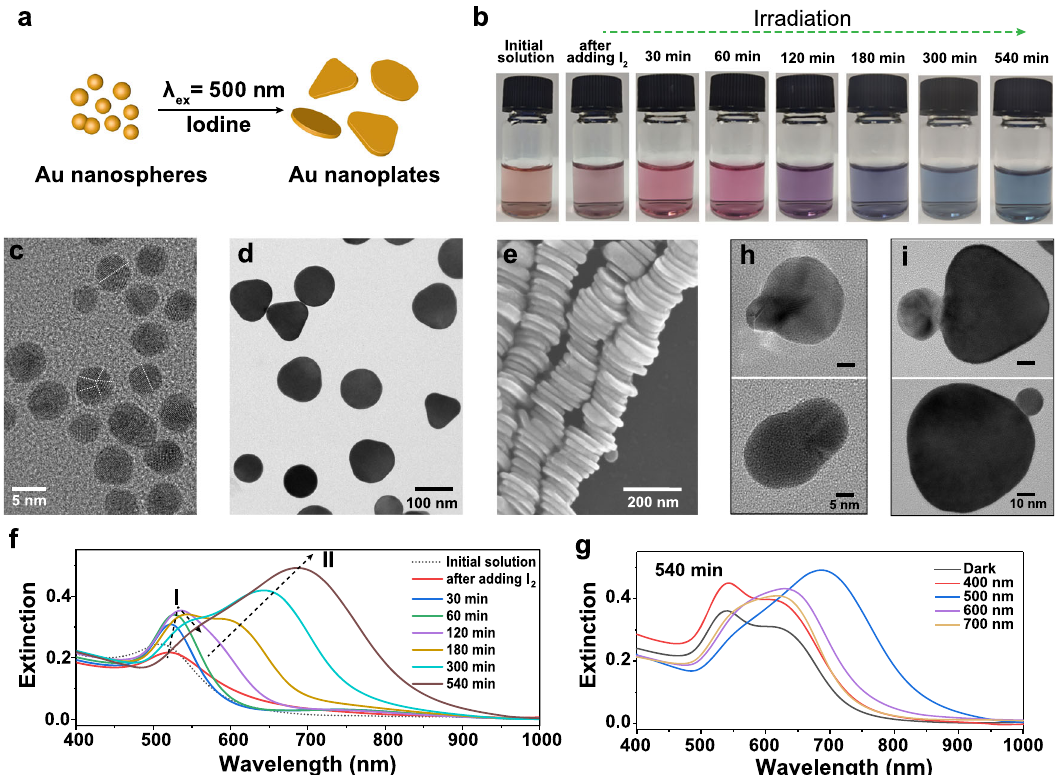
Fig. 1 Photoinduced conversion from Au nanospheres to Au nanoplates. a Schematic illustration of the photoinduced conversion of Au nanospheres to nanoplates in the presence of iodine with irradiation at 500 ± 10 nm light. b Photograph of the initial Au nanospheres solution, and the reaction solution under continuous light (500 ± 10 nm) irradiation after adding 170 μ l of I 2 aqueous solution (0.5 mM). c TEM image of the Au nanospheres. The white dotted line as a guide highlights the boundaries of the twins (HRTEM images of more Au nanospheres are shown in Supplementary Fig. 1). d , e TEM and SEM images of fi nal products obtained via irradiation of the reaction solution with light for 540 min (HRTEM image of Au nanoplate is displayed in Supplementary Fig. 2). f Time-dependent UV – Vis spectra of the corresponding solution in ( b ). g UV – Vis spectra of solution after 540 min reaction in dark condition, under 400 ± 10, 500 ± 10, 600 ± 10, and 700 ± 10 nm light excitation. h , i TEM images of the intermediate products after 60 and 300 min conversion reaction,